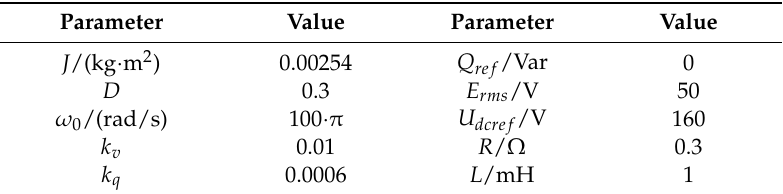
Figure 18. The scheme of the experiment. Table 2. Experiment parameters.